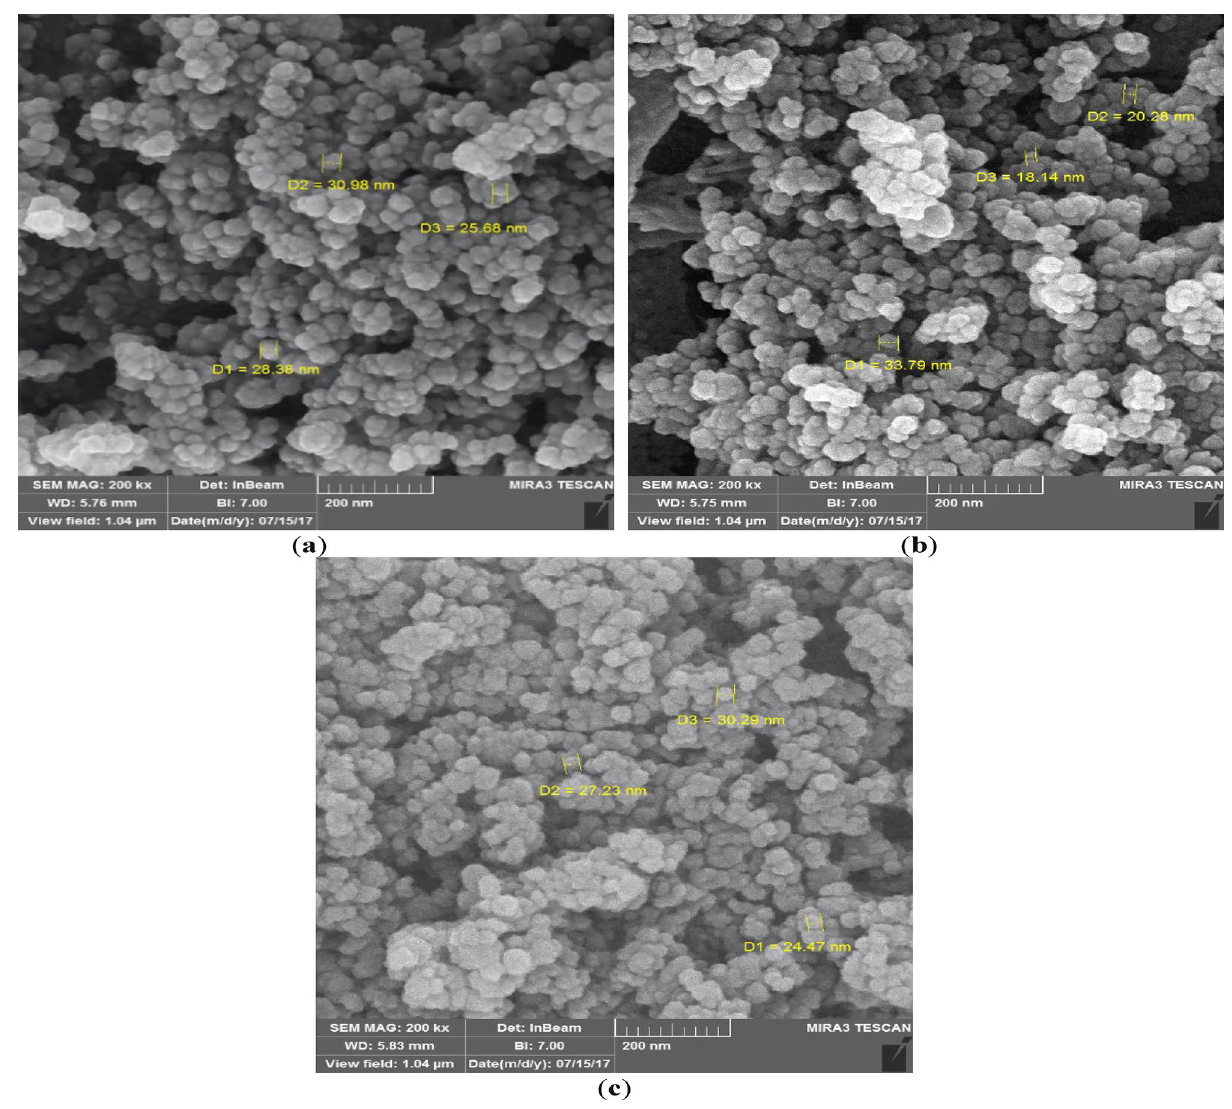
Figure 1. FESEM images of ( a ) TiO 2 , ( b ) chitosan, and ( c ) TiO 2 –chitosan